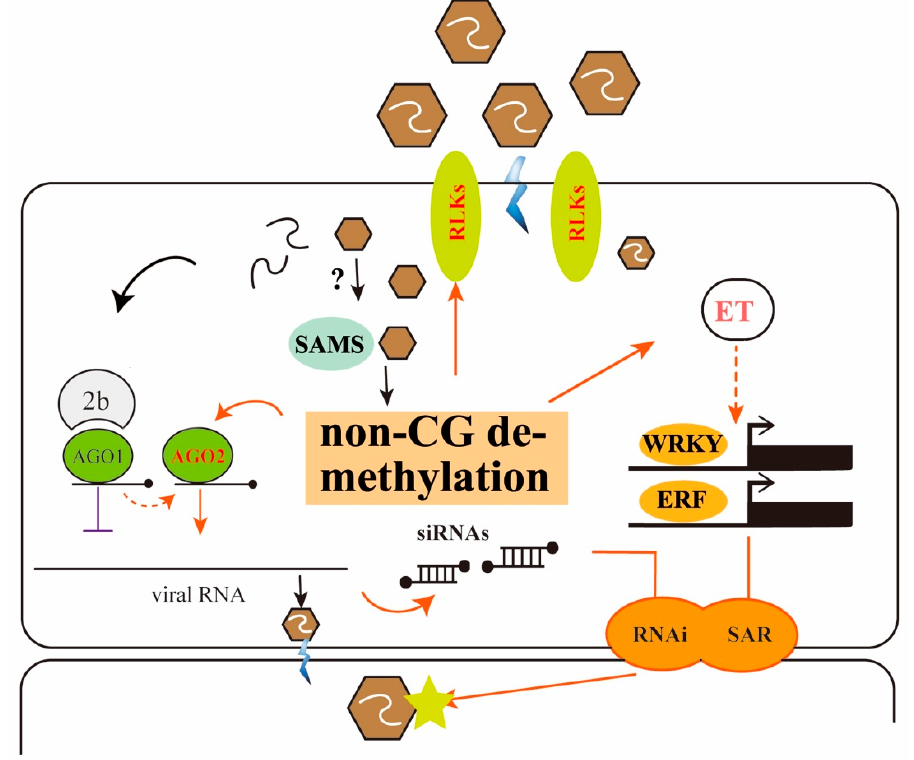
Figure 5. Proposed model for tobacco epigenetic change in response to CMV infection. Virions are recognized by hypomethylated plant RLKs that act as membrane-associated or transmembrane proteins. SAMS were depressed under unknown mechanisms to regulate DNA methylation. Over-accumulated AGO2 proteins due to hypomethylation results in antiviral silencing and thus could be acting as a second defense layer. Key components of hormone signaling, such as ERF and WRKY family, are hypomethylated and significantly expressed and transmitted to developmental tissues as systematic resistance for recovery of new leaves. These two components of plant defense signals are transferred to new leaves for antiviral activity. Arrows in orange represent methylation regulation in response to viral infection. Arrows in dotted lines and question represent possible biological process. The red text indicates genes or pathways regulated by DNA methylation or demethylation.